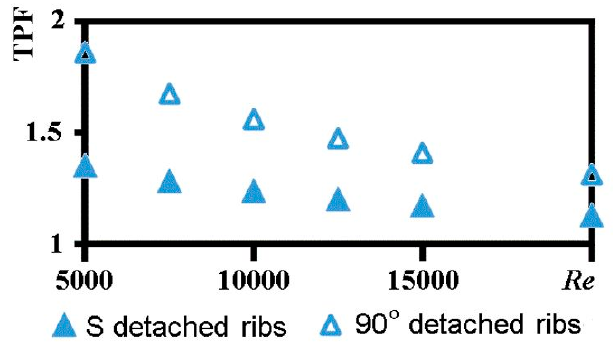
Figure 6. Variations of thermal performance factors (TPF) against the Reynolds number for the twin-pass parallelogram channels with detached S-ribs and 90° ribs [18].